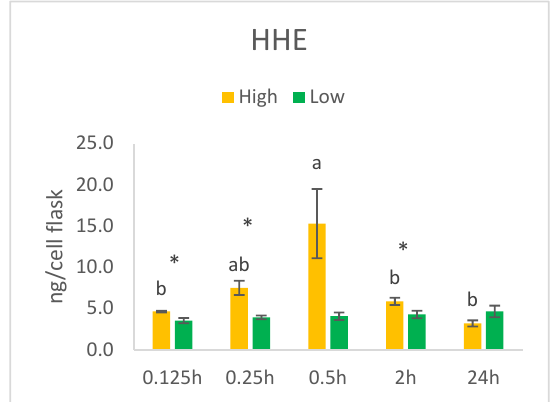
Figure 6. HHE (ng/cell pellet) in HT29 cells exposed to high (140 µM) or low (0.014 µM) concentrations of HHE. Data (n = 4) are means shown with standard error mean. Significant differences within Low or High groups are indicated with different letters evaluated with Tuke—HSD ( p < 0.05). Significant differences ( p < 0.05) between Low and High evaluated by Student’s t -test are indicated with asterisk (*) at specific time